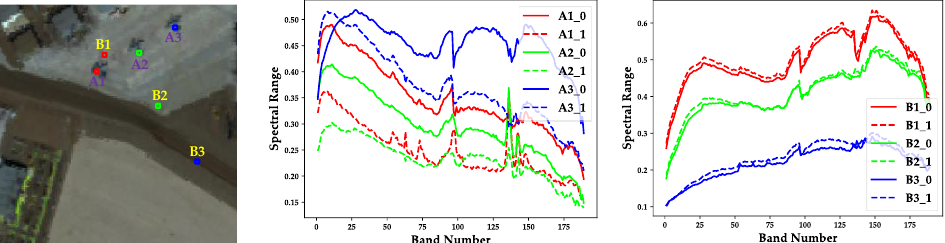
Figure 4. Comparison of the original and reconstructed spectral information on San Diego-II. Here, “A1_0” represents the anomalous pixel “A1” in original HSI. “A1_1” indicates the anomalous pixel “A1” in the reconstructed HSI. Similarly, “B1_0” and “B1_1” signify the background pixel “B1” in original HSI and reconstructed HSI, respectively.